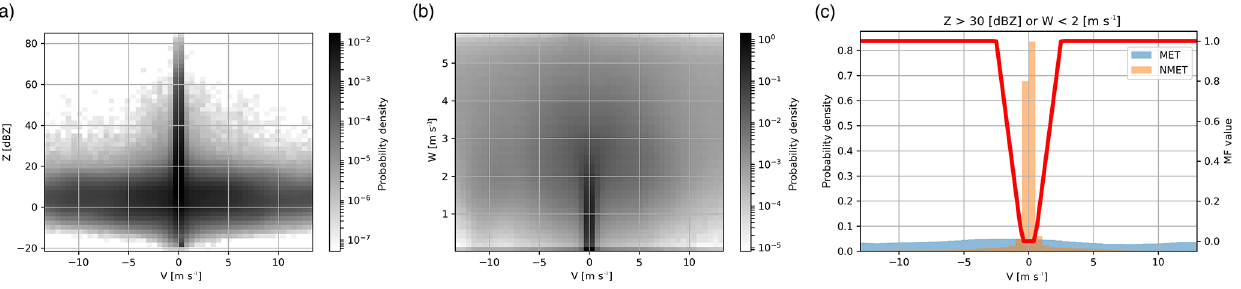
Figure 5. (a) The 2-D histogram of V vs. Z of NMET. (b) The 2-D histogram of V vs. W of NMET. (c) The normalized frequency distribution and membership function of V after setting thresholds of Z and W